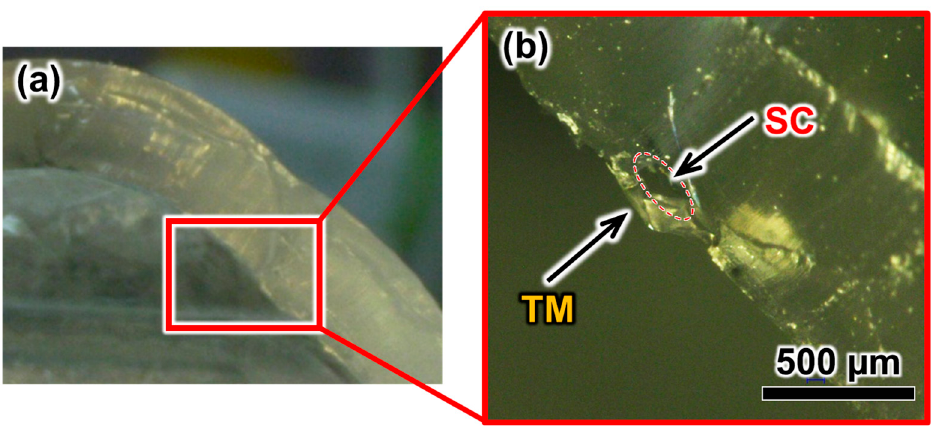
Figure 5. Sectional images of the fabricated eye model: ( a ) Cross-sectional image of the whole eye model; ( b ) high-magnification image of the angle for the tube structure of the SC covered with artificial TM.